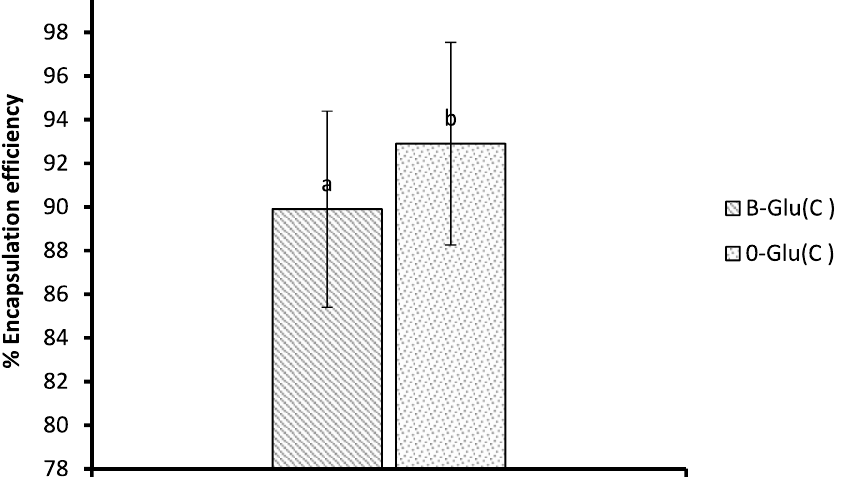
Figure 4. Encapsulation efficiency of B-Glu (C) and O-Glu (C). Here, B-Glu(C) represents catechin encapsulated into a β -glucan matrix and O-Glu(C) represents catechin encapsulated into oats β - glucan matrix. Different letters on the bars indicate significant difference ( p <